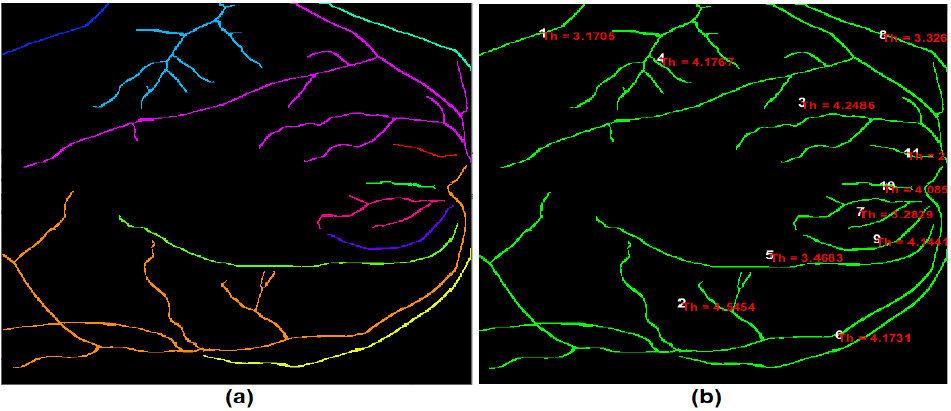
Figure 8. The output of the developed thickness procedure: ( a ) coloured labelled retinal blood vessels; and ( b ) image map for the retinal blood vessels along with their indexes and average thickness values.